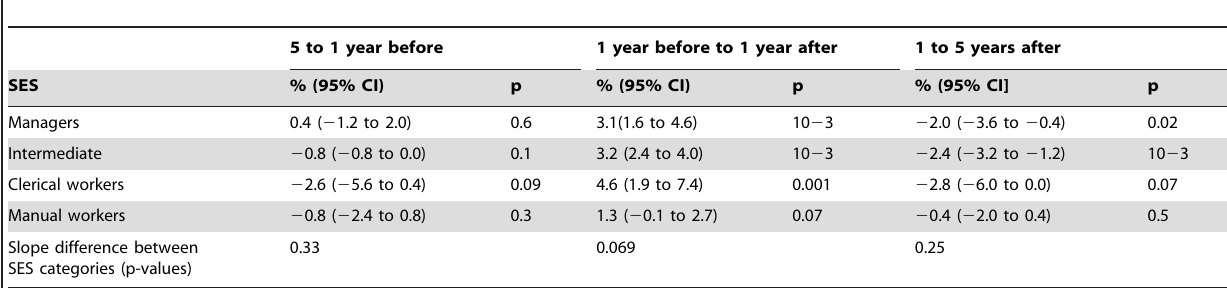
Table 3. Change in the proportion of heavy drinkers during 3 periods surrounding retirement by SES in men (from generalised estimation equations